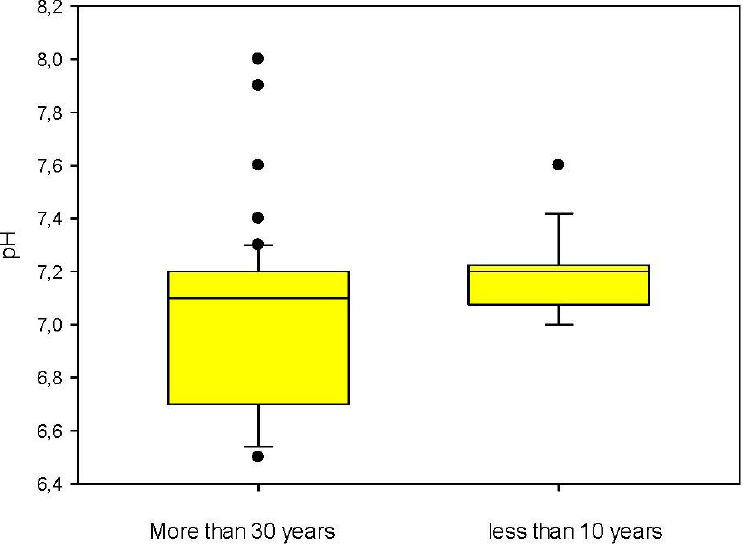
Figure 4. Experimentally determined pH values measured in vessel aged more than thirty years and less than ten years. The distribution is shown by a vertical box plot as the median (lines), 25th and 75th percentiles (boxes) and 90th and 10th percentiles (whiskers). Circles mark the